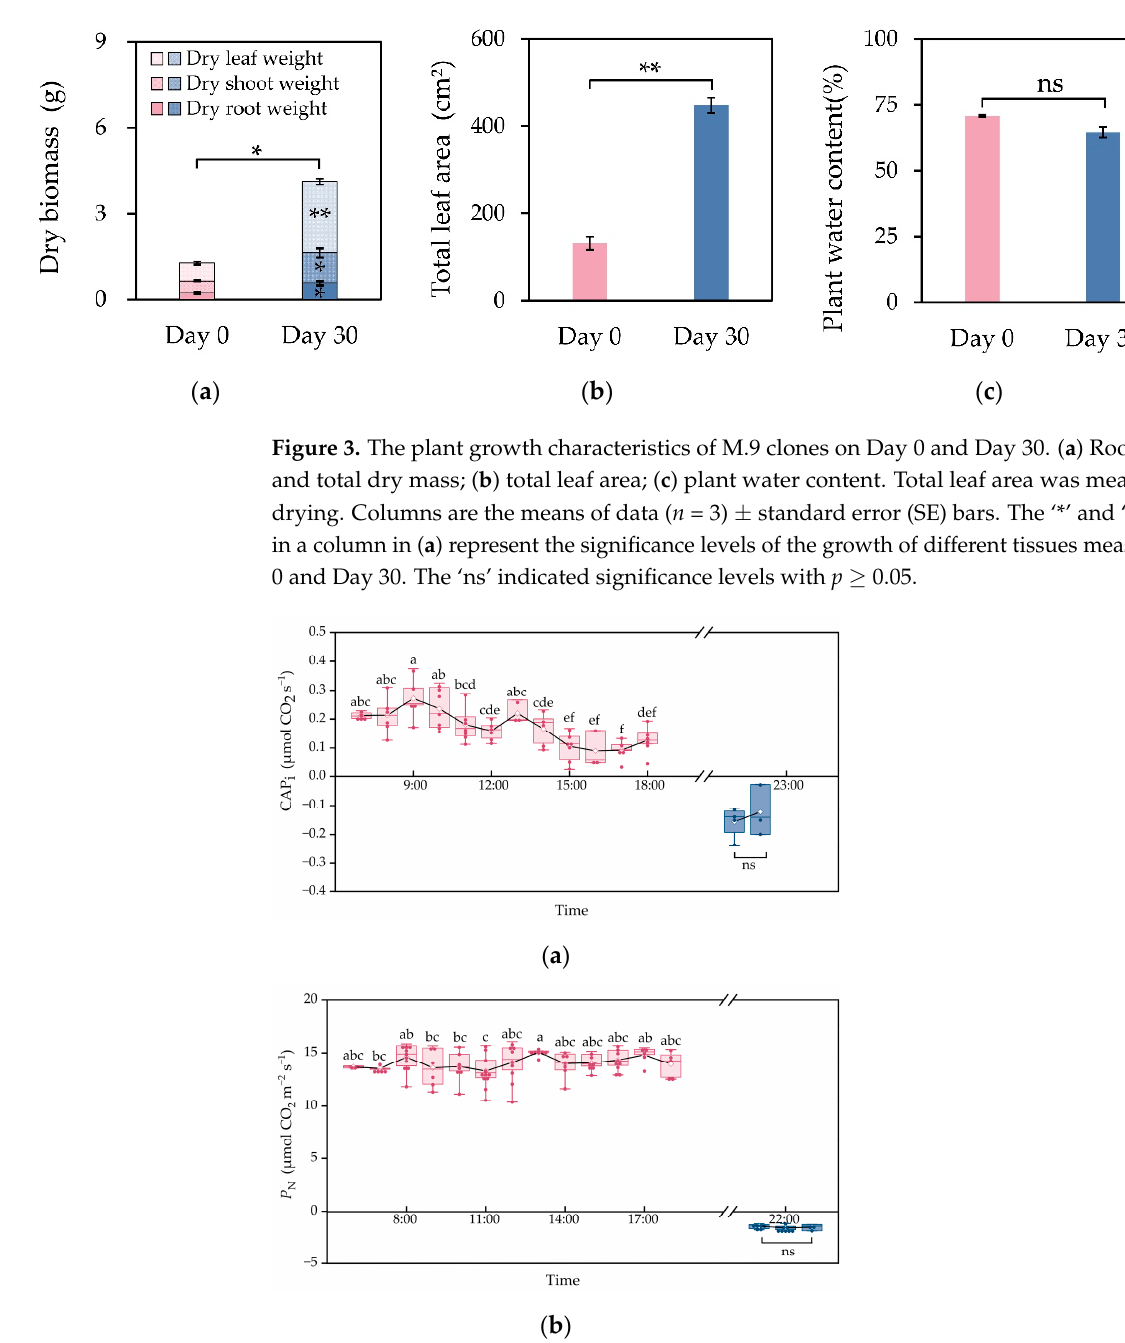
Figure 4. The diurnal fluctuation of instantaneous photosynthesis parameters of M.9 clones. ( a ) Canopy apparent photosynthesis (CAP i ); ( b ) leaf net photosynthetic rate ( P N ). The average value ( n = 3) and median are indicated by a hollow point and transverse line in each box separately. The solid points represent data points. The upper and lower edges of a box are the 90th and 10th corresponding to percentiles respectively. Different letters after mean values ± standard error in the same column indicate the significant difference determined by the least significant difference (LSD) test with p < 0.05.